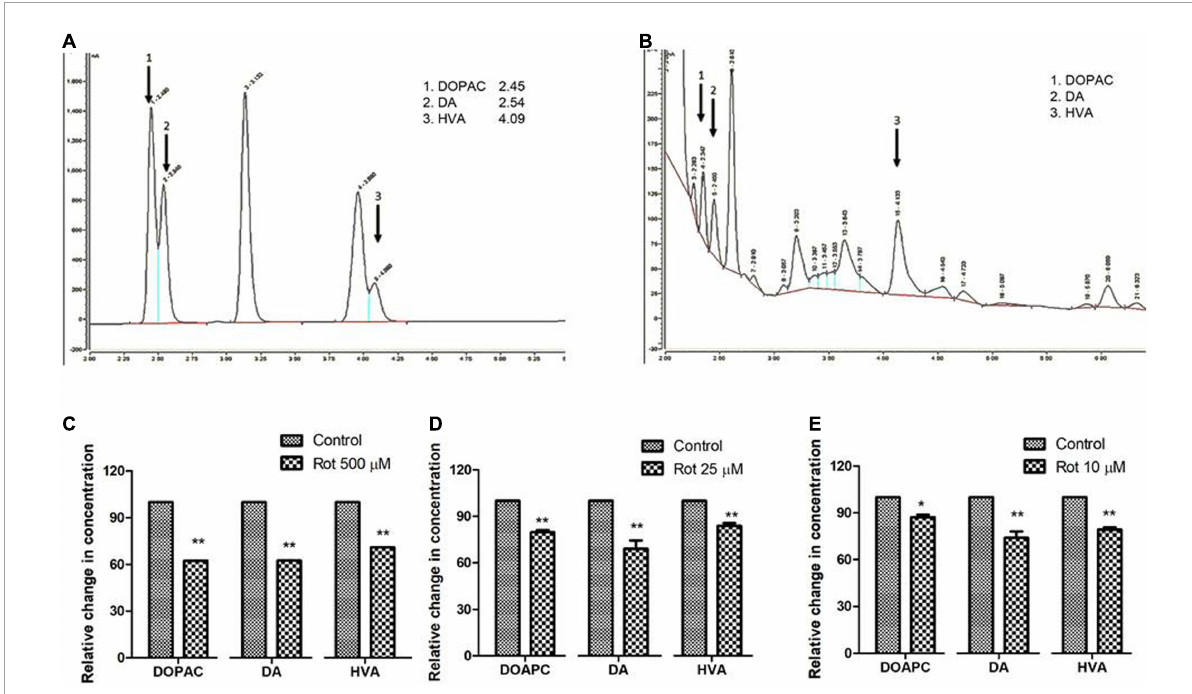
FIGURE5 Quantification of DA and its metabolites, HVA, and DOPAC using HPLC in fly brain homogenate: Chromatogram of standard DA, HVA, and DOPAC (A) shows specific retention time and chromatogram for fly brain tissue extract (B) . The relative level of DA and its metabolites at the selected time points in three stages of the life span, that is, early health span (C) ; late health span (D) ; transition phase (E) indicates diminished levels of DA, HVA, and DOPAC illustrating altered DA metabolism in brain-specific fashion in the PD model. Statistical analysis was performed using a t -test (compared to control). * p < 0.05, ** p < 0.001.